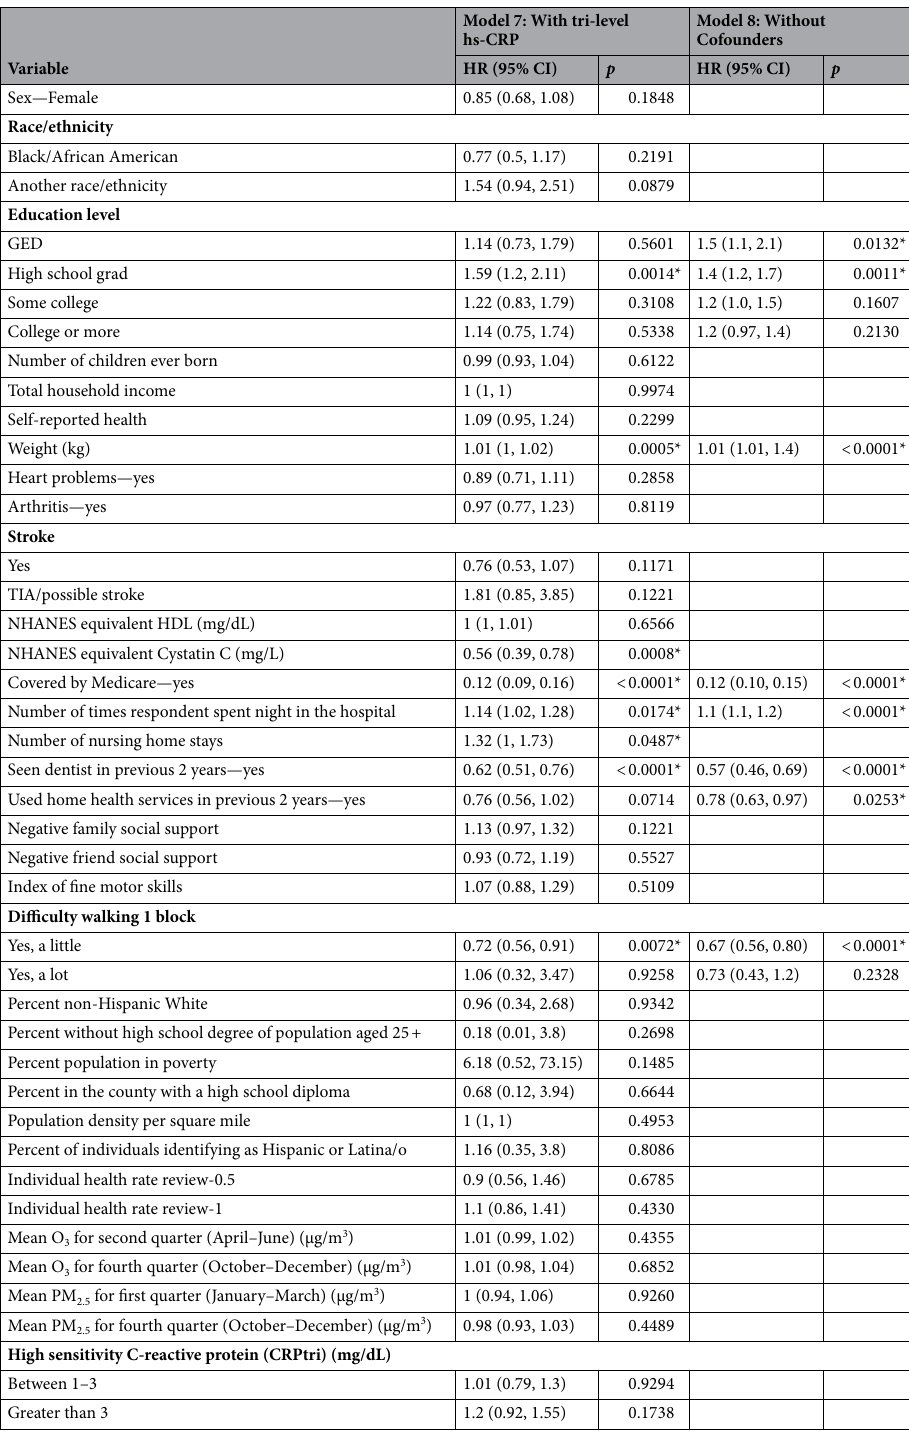
Table 5. Hazard ratios from Cox proportional hazards model of short telomere length. hs-CRP high sensitivity C-reactive protein, HR hazards ratio, CI confidence interval; N = 2,813 cox proportional hazards model with tri-level hs-CRP. * p < 0.05 as significant findings in the